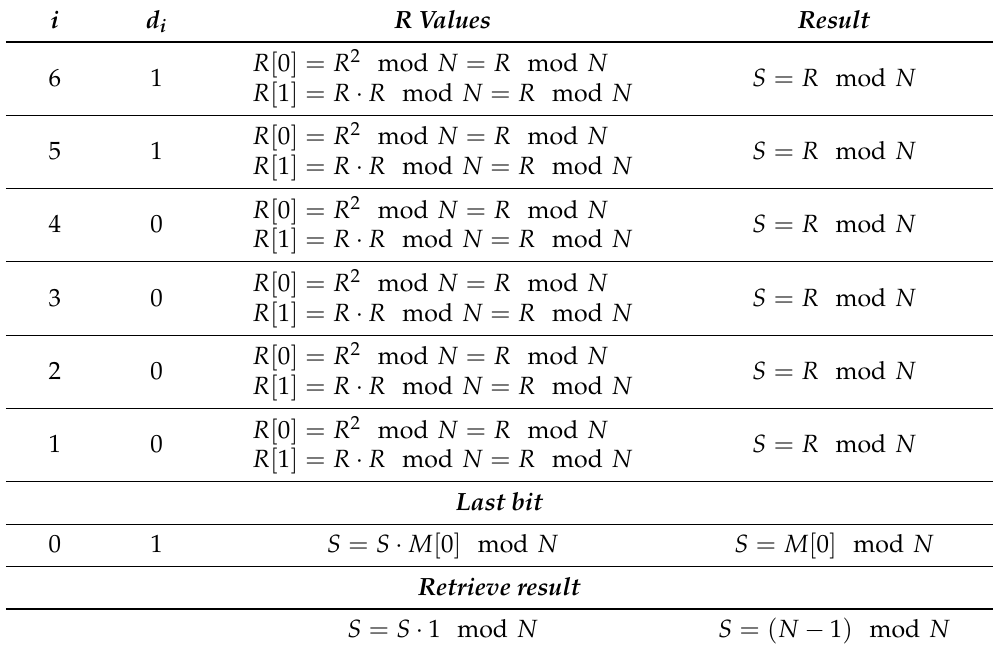
Table 3. Example of the execution of the proposed